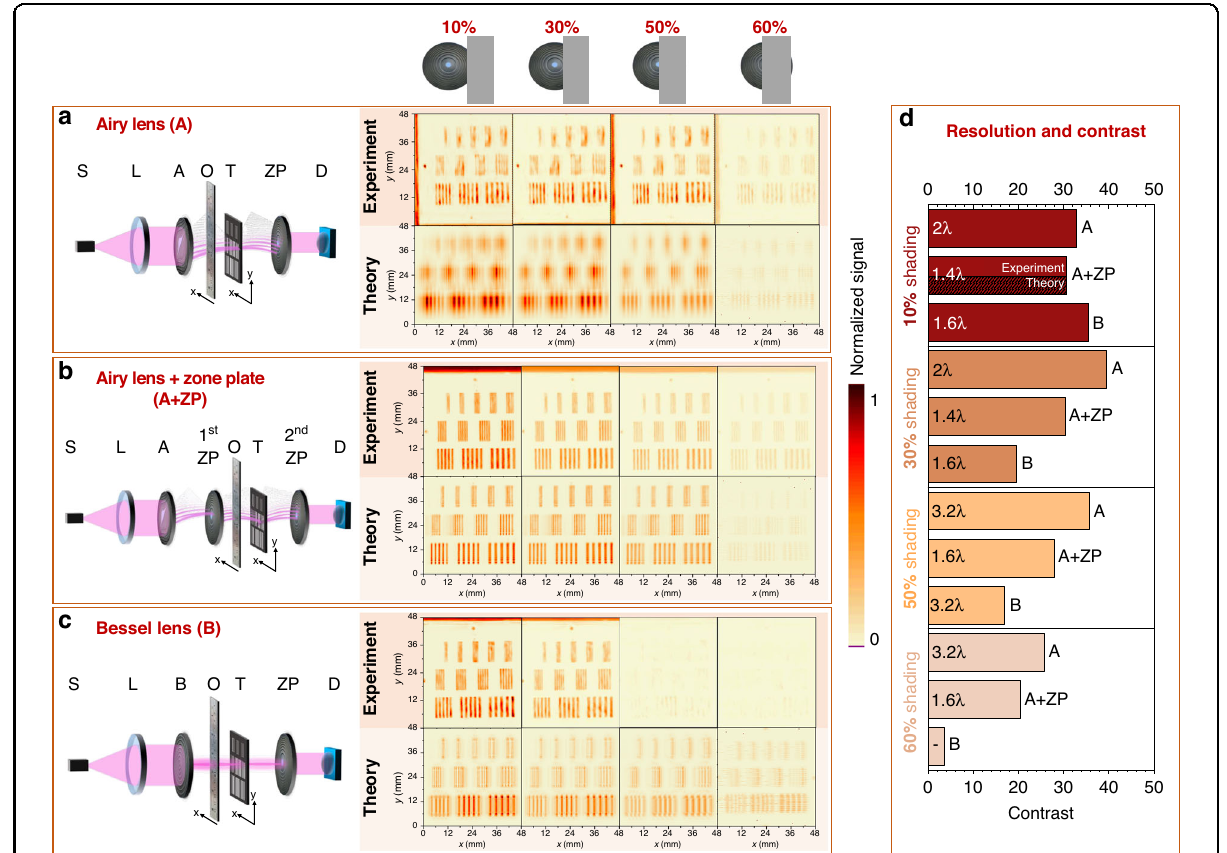
Fig. 4 Benchmarking of structured nonparaxial illumination behind the obstacle. Performance of the nonparaxial Airy phase mask in THz imaging behind the obstacle in two setups: with the single nonparaxial zone plate ( a ) and two nonparaxial zone plates ( b ), where O denotes an obstacle. Performance of the nonparaxial Bessel phase mask in the same THz imaging behind the obstacle setup ( c ). The color bar is normalized to the maximum value of the signal for each setup. The position of the obstacle is depicted on top of four columns on the right, starting from the almost uncovered object (middle, ∼ 10% is covered) and ending with the most covered object (right, ∼ 60% is covered). Results of resolution and contrast benchmarks for different coverage of the structured illumination percentage ( d ). Resolution values are marked inside the colored bars, the contrast is given on the x-axis. For the sake of brevity, the numerical estimate is given only for one particular case, since in all other cases the results between theory and experiments are well-coincident within 2 percent accuracy. The contrast is de fi ned as the ratio of the maximal and minimal intensity